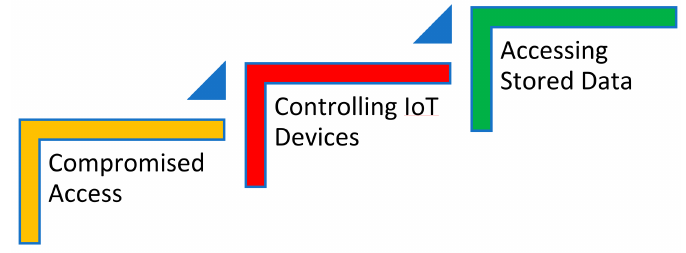
Figure 5. Stages of IoT threats in general.